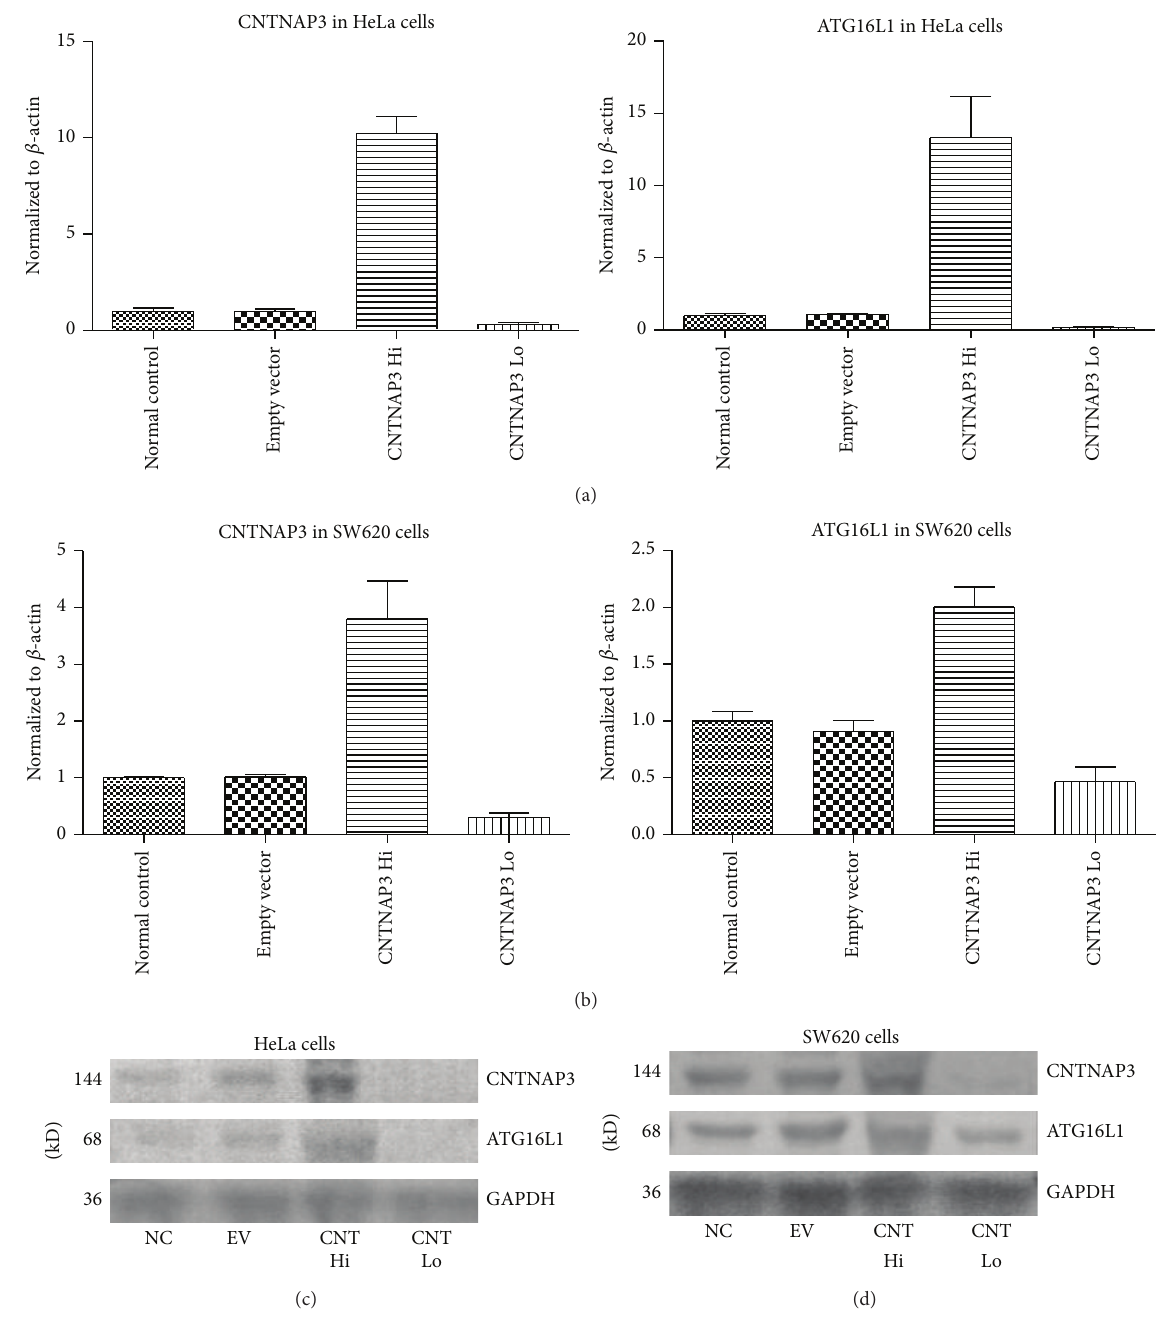
Figure 3: Level of ATG16L1 after CNTNAP3 manipulation. Seventy-two hours after transfection, ATG16L1 was lower in CNTNAP3 knockdown cells than that in cells transfected with empty vectors (HeLa, 𝑃 = 0.013 and SW620, 𝑃 = 0.005 ). (a and b). On the other hand, ATG16L1 was significantly higher in cells transfected with CNTNAP3 overexpression plasmid than that in cells transfected with empty vectors (HeLa, 𝑃 = 0.001 and SW620, 𝑃 = 0.052 ) (a and b). There was no significant difference between cells transfected with empty vectors and normal controls (HeLa, 𝑃 = 0.630 and SW620, 𝑃 = 0.517 ). Similarly, western blot indicated that ATG16L1 protein expression was significantly associated with the expression of CNTNAP3 manipulations. ATG16L1 protein expression significantly decreased and increased 72 hours after CNTNAP3 siRNA interference and CNTNAP3 overexpression, respectively (c and